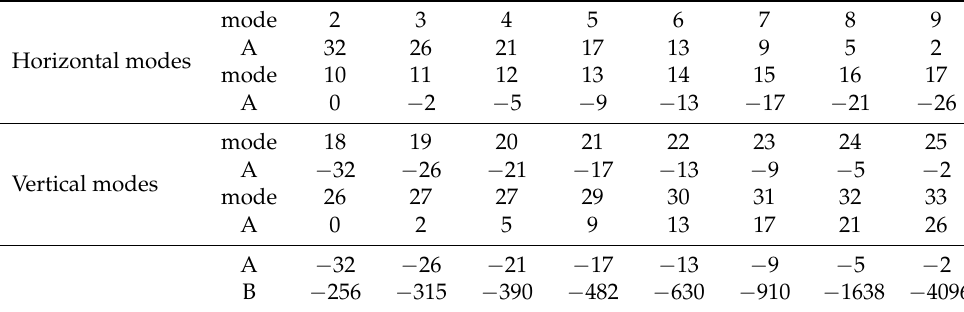
Table 2. Angular A and B parameters lock-up